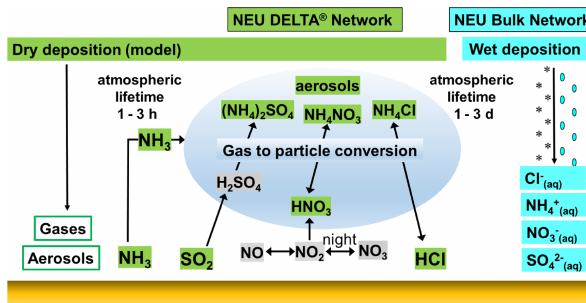
Figure 1. Reaction scheme for the formation of ammonium aerosols from interaction of NH 3 with acid gases HNO 3 , SO 2 , and HCl, showing the components (green) that were measured in the Ni- troEurope (NEU) DELTA ® network. Dry deposition of the gas and aerosol components was estimated by inferential modelling (Flechard et al., 2011), while wet deposition (blue) was measured in the NEU bulk wet-deposition network at a subset of the DELTA ®